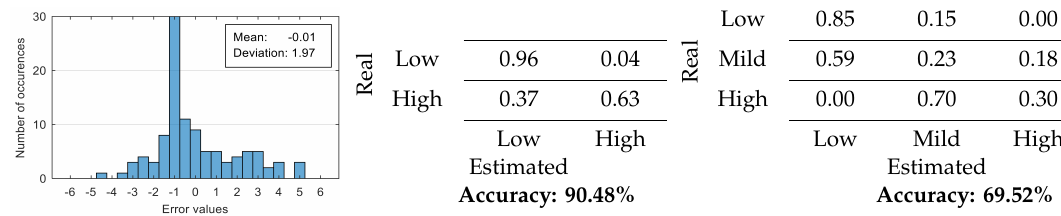
Table 6. Distribution of estimation errors and confusion matrices for levels 2 and 3—using one